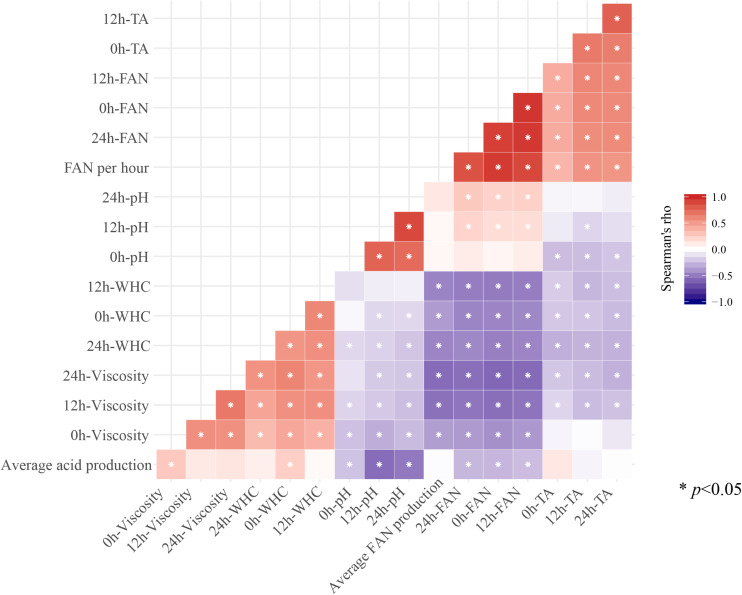
The correlation between fermentation characteristic index and fermentation characteristic index during storage (∗ means p < 0.05).